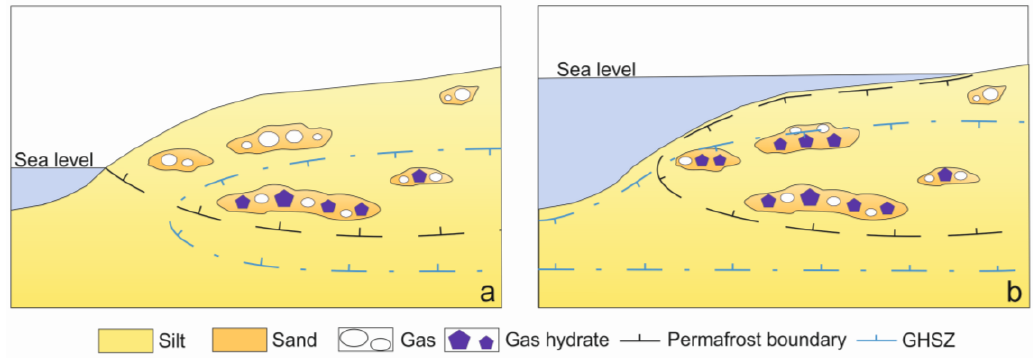
Figure 13. Pore hydrate formation in gas-saturated permafrost under ice load: ( a ) prior to glaciation; and ( b ) after to glaciation.